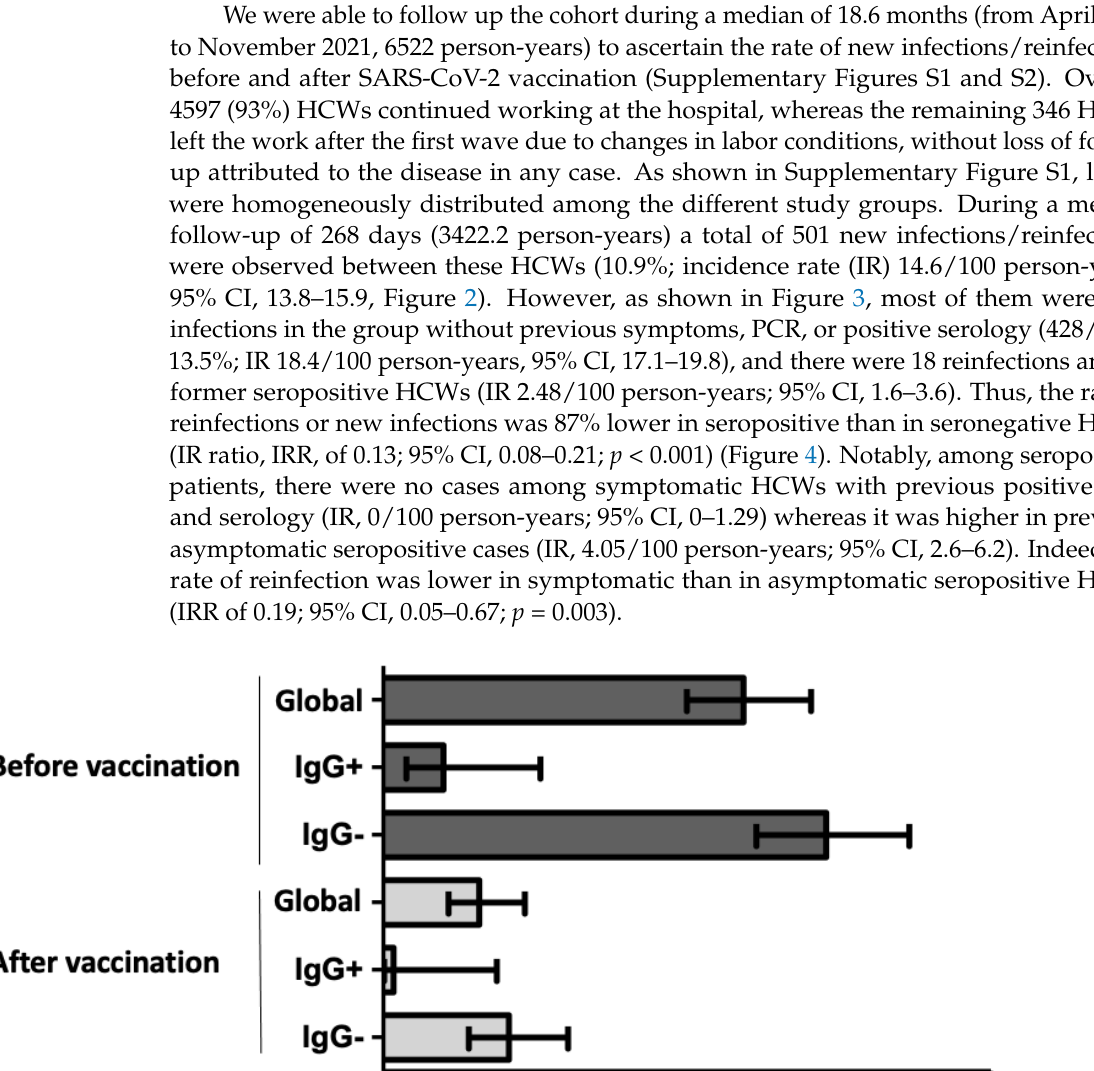
Figure 3. Incidence rates (95% confidence interval) of new infections/reinfections in function of the five different subgroups of the study (dark grey bars, before vaccination; grey bars, after vaccination). PCR, polymerase chain reaction; Serol, anti-N specific serology.